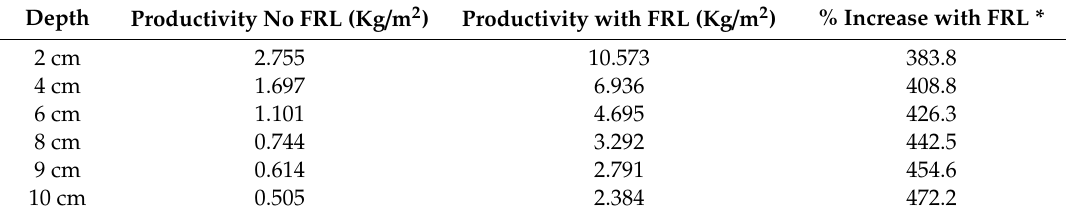
Table 8. Predicted productivity with and without FRL for varying water